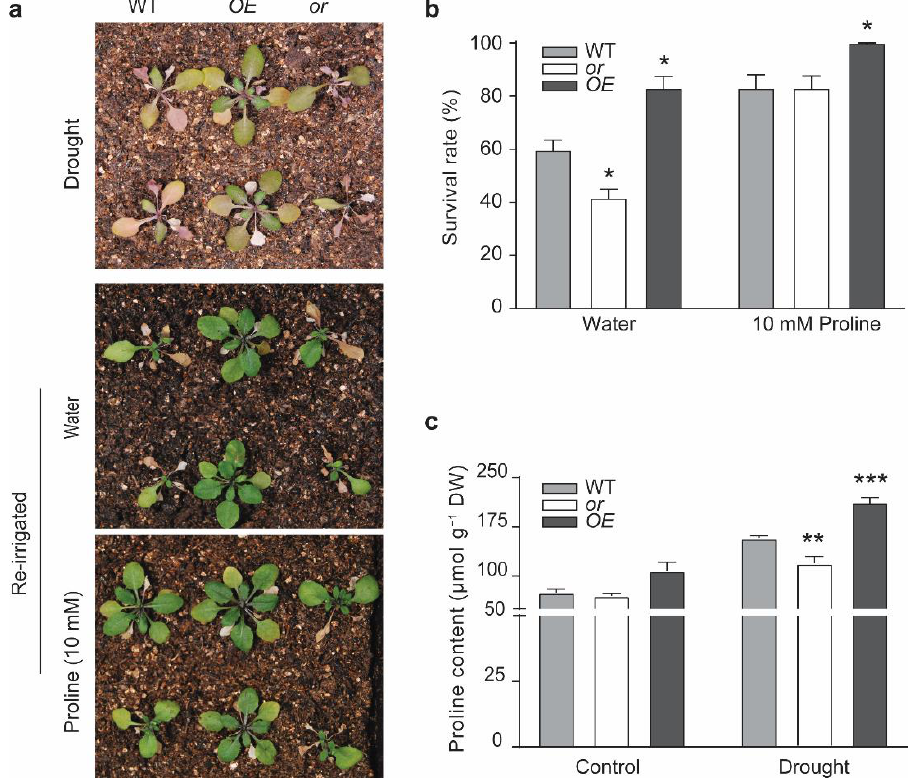
Figure 5. OR transgenic seedlings showed different proline levels under drought treatment. ( a ) Rep- resentative seedlings of the wild-type (WT) and OR -overexpressing ( OE ) and -silencing ( or ) lines under drought treatment and re-irrigated with water or 10 mM proline for 5 d. ( b ) Survival rate of water or proline re-irrigated WT, OE , and or seedlings. Data are means ± SEM ( n = 9, * p < 0.05, Student’s t test). ( c ) Proline contents in drought or PEG6000 (15%)-treated WT, OE , and or seedlings. DW, dry weight. Data are means ± SEM ( n = 3, * p < 0.05, ** p < 0.01, *** p < 0.001, or better, Student’s t test).